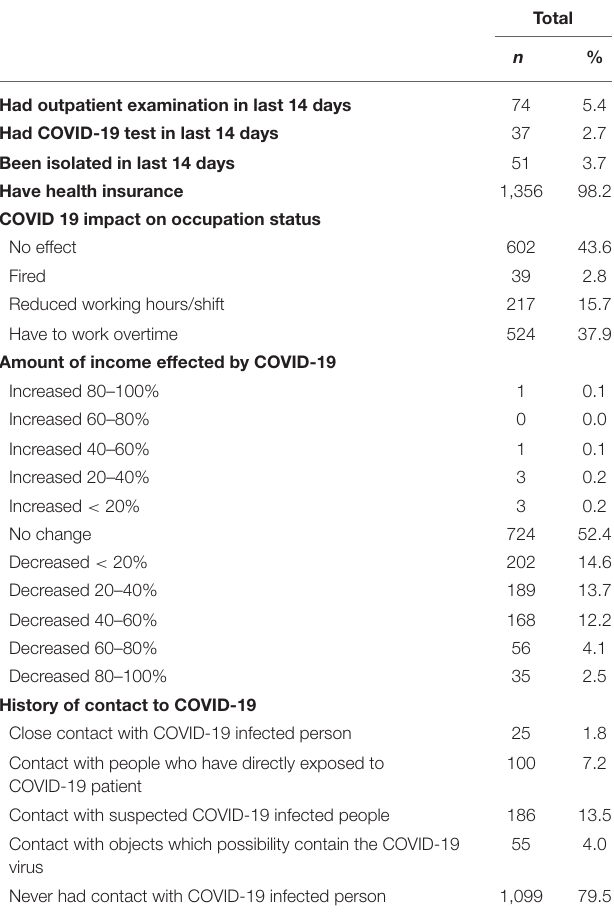
TABLE 2 | Impact of COVID-19 on participant life.